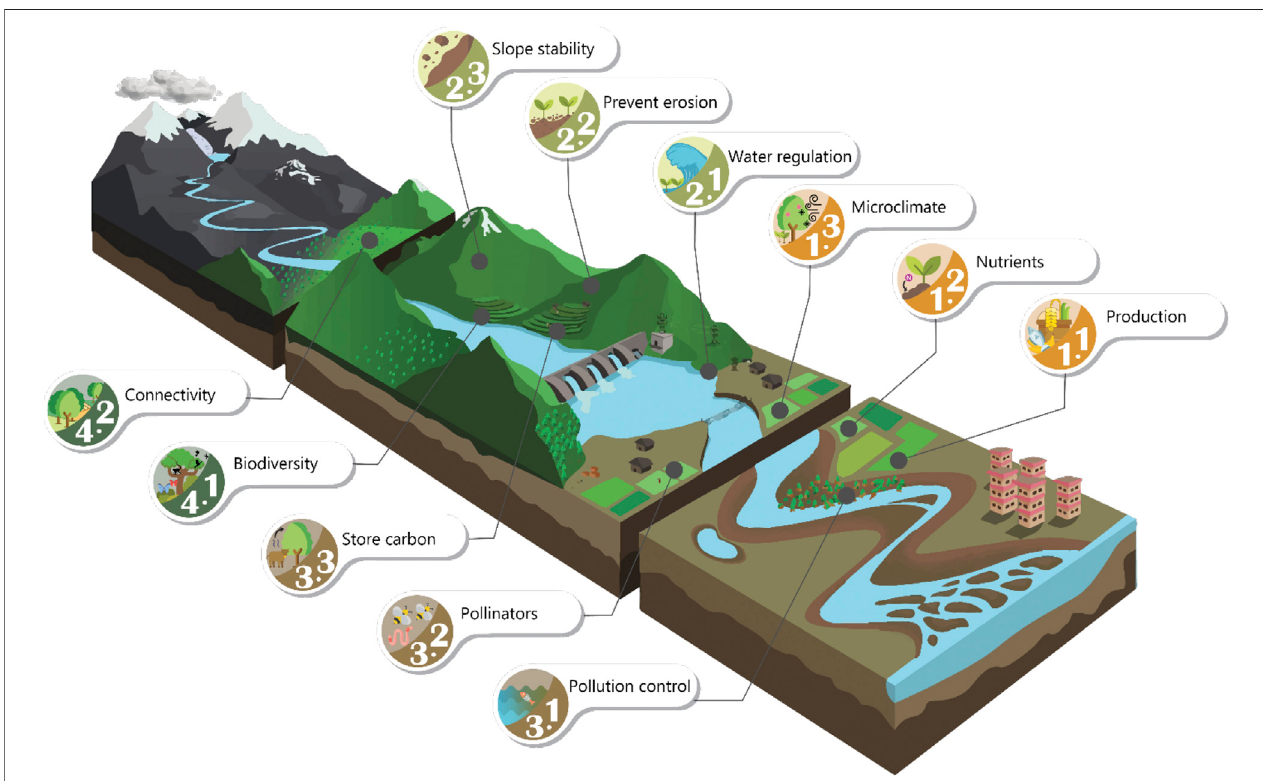
FIGURE2| NBSforagriculturelandscapes.Thecorrespondingnumbersarefoundin Table2 .Source:LandscapefromICIMOD(http://www.icimod.org/?q (cid:1) rps_ riverbasins). Wave (2.1) Abstract vector created by freepik - www.freepik.com. Landslide (2.3) original icon from www.clipartmax.com. Bee (3.2) and tree (4.1) original iconsmadebySmashiconsfromwww. fl aticon.com.Cow(3.3)iconmadebyNhorPhaifromwww. fl aticon.com.AllothericonsmadebyFreepikfromwww. fl